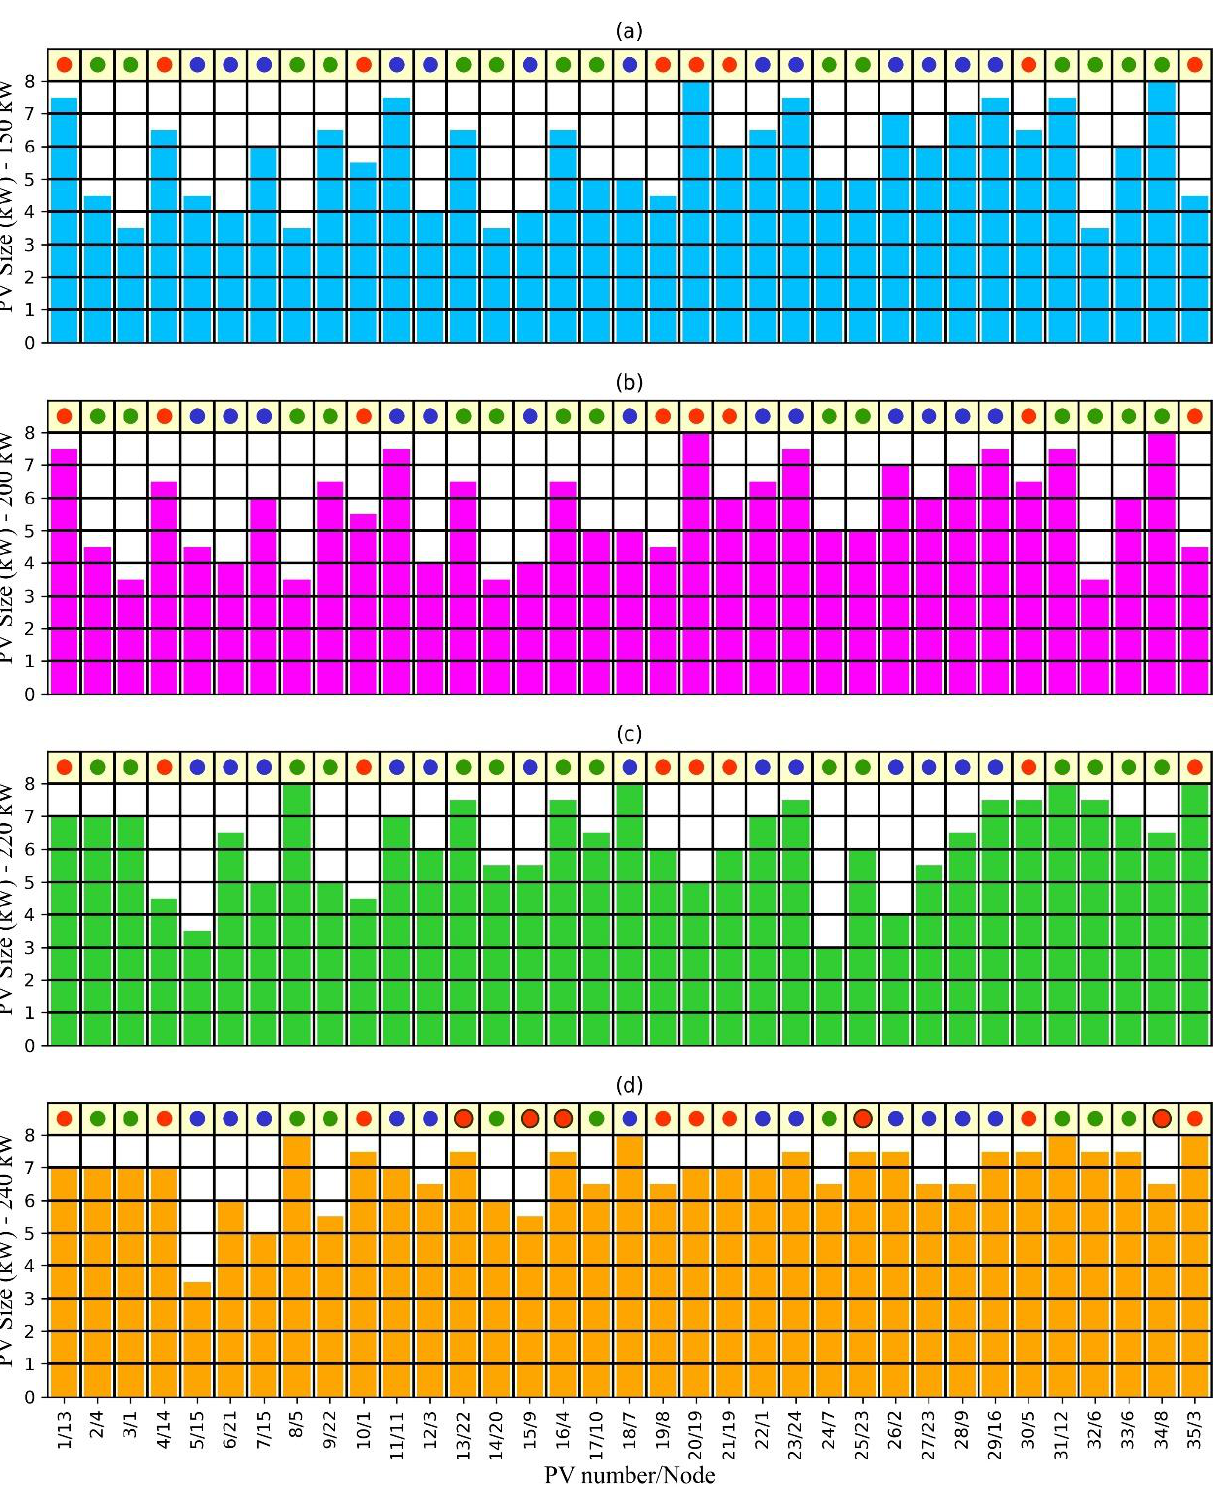
Figure 9. Variation of the PV sizes and the connected phases in different total PV capacities. ( a ) 150 kW, ( b ) 200 kW, ( c ) 220 kW, and ( d ) 240 kW